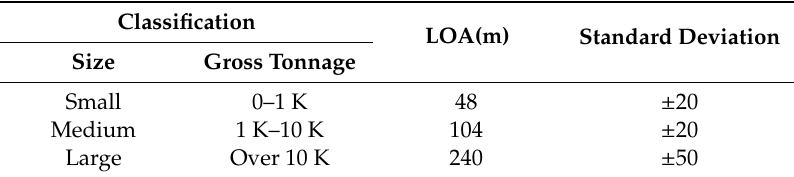
Table 2. Classification of ships by size according to precedent study.